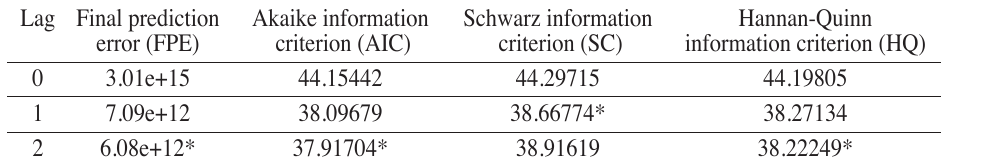
Table 3: Results of the lag selection criteria